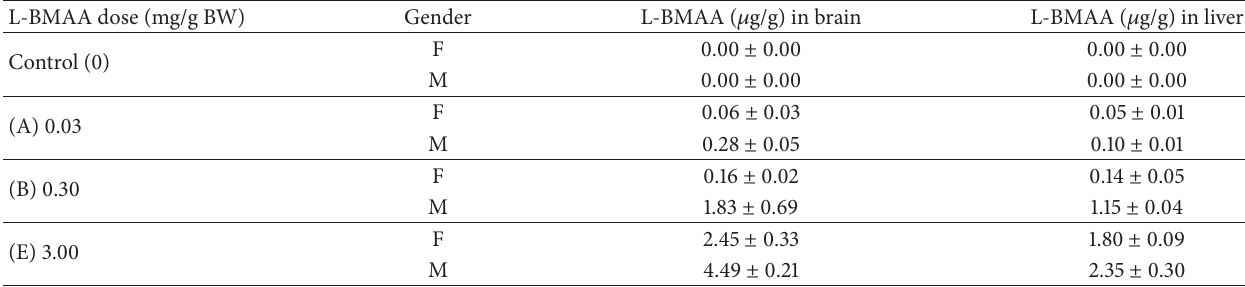
Table 3: L-BMAA concentrations ( 𝜇 g/g) in brains and livers of mice as detected by UPLC-UV. Each value is the mean of three replicates ± standard deviation. BW: body weight; F: female; M: male. A, B, and E: mice treated (0.03, 0.3, and 3mg/g BW) groups. L-BMAA dose (mg/g BW)